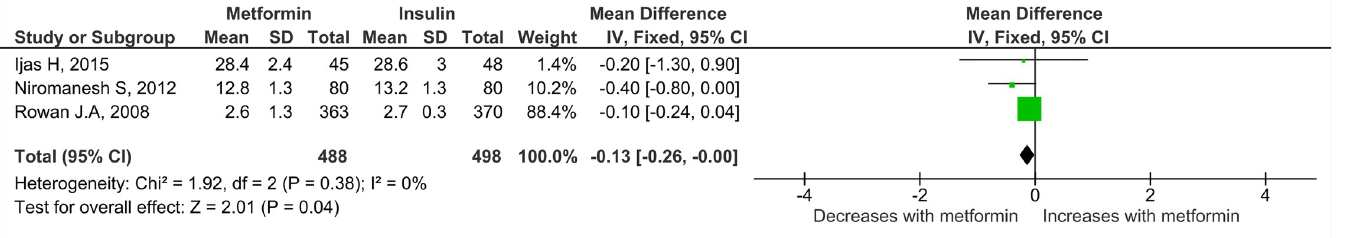
PLOS Medicine| https://doi.org/10.1371/journal.pmed.1002848 August 6,